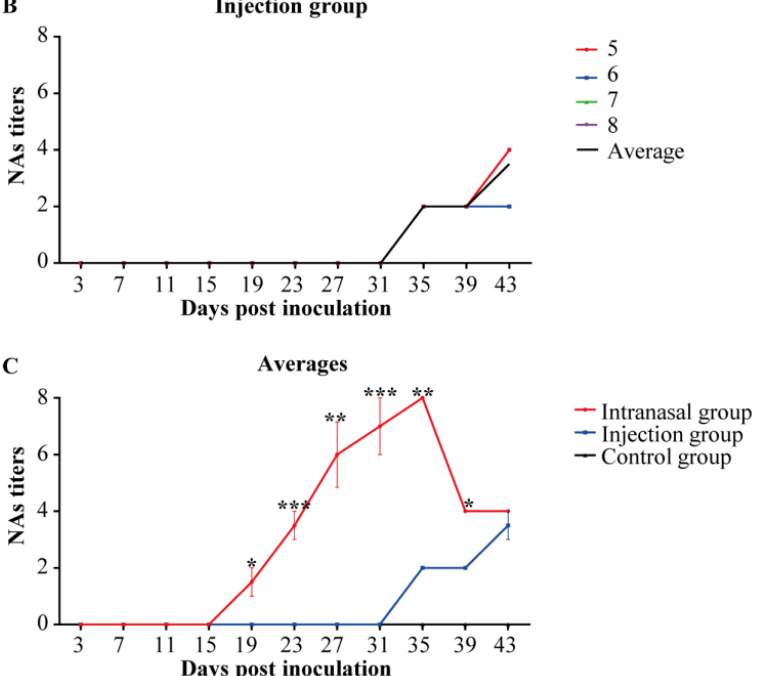
Figure 6. Anti-PRRSV saliva NAs titers. The micro-neutralization assay results were determined by evaluating PRRSV RNA using RT-qPCR. NAs titers were below 1:2 in the control group throughout the study. ( A , B ): Colored lines represent the individual animals, and black lines represent the mean value of each group. Numbers (1–9) represent the individual pig numbers. ( A ) Anti-PRRSV saliva NAs titers in the intranasal group. ( B ) Anti-PRRSV saliva NAs titers in injection group. ( C ) The averages of saliva NAs titers within each group. The graph illustrates the mean ± SEM. Statistical differences were determined using the t -test (* p < 0.05; ** p < 0.01; *** p < 0.001). Comparisons were between the Intranasal and the Injection groups.